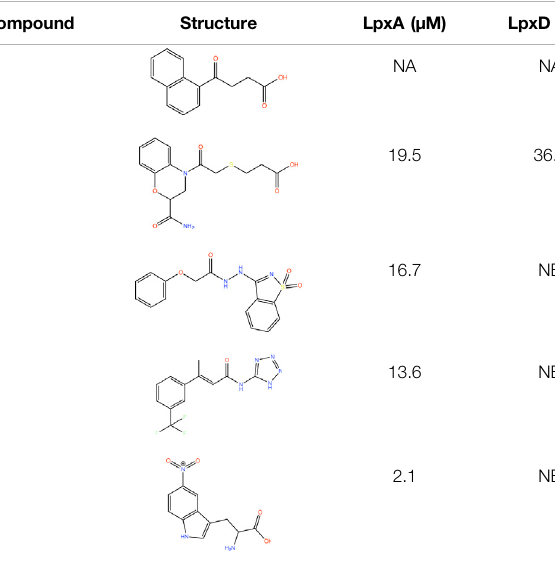
TABLE 2 | Binding af fi nities to Pa LpxA and Pa LpxD of the novel small-molecule scaffolds identi fi ed following an FBDD campaign. A few of them show